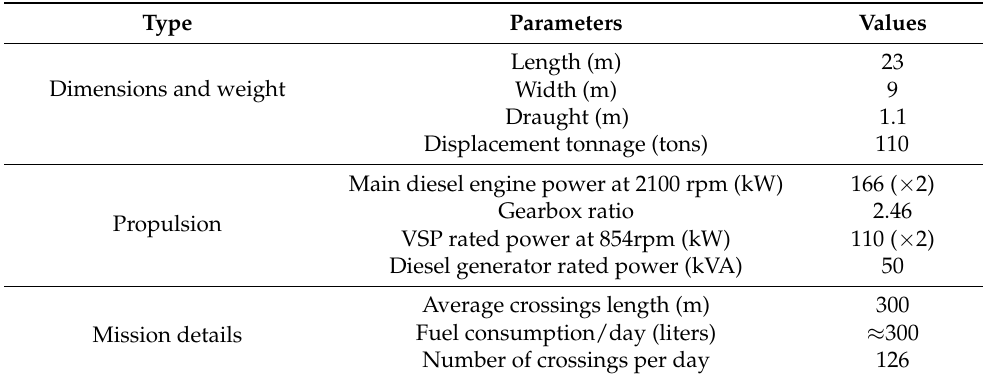
Figure 1. Studied river ferry ( a ) and simplified schema of its conventional propulsion (only one set of diesel–gearbox–propeller is represented) ( b ). Table 1. Main characteristics of the studied river ferry.